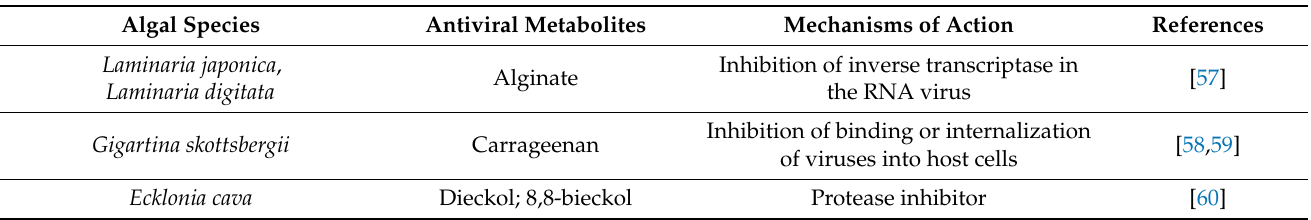
Table 1. List of algae-derived metabolites and their bioactivity as antiviral compounds. Algal